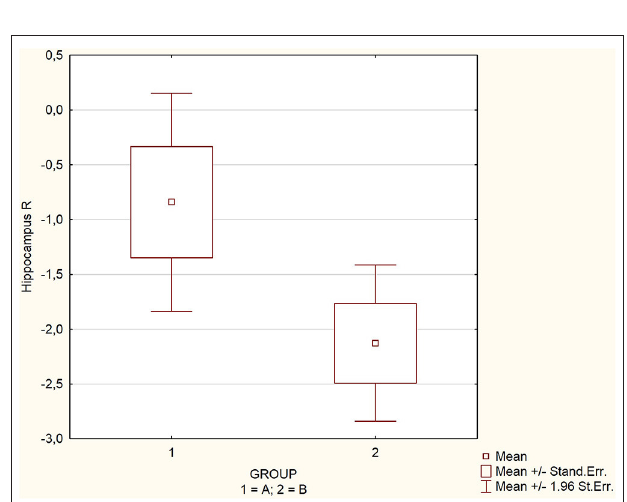
FIGURE 2 | Comparison of perfusion in regions significantly affected by glycemic